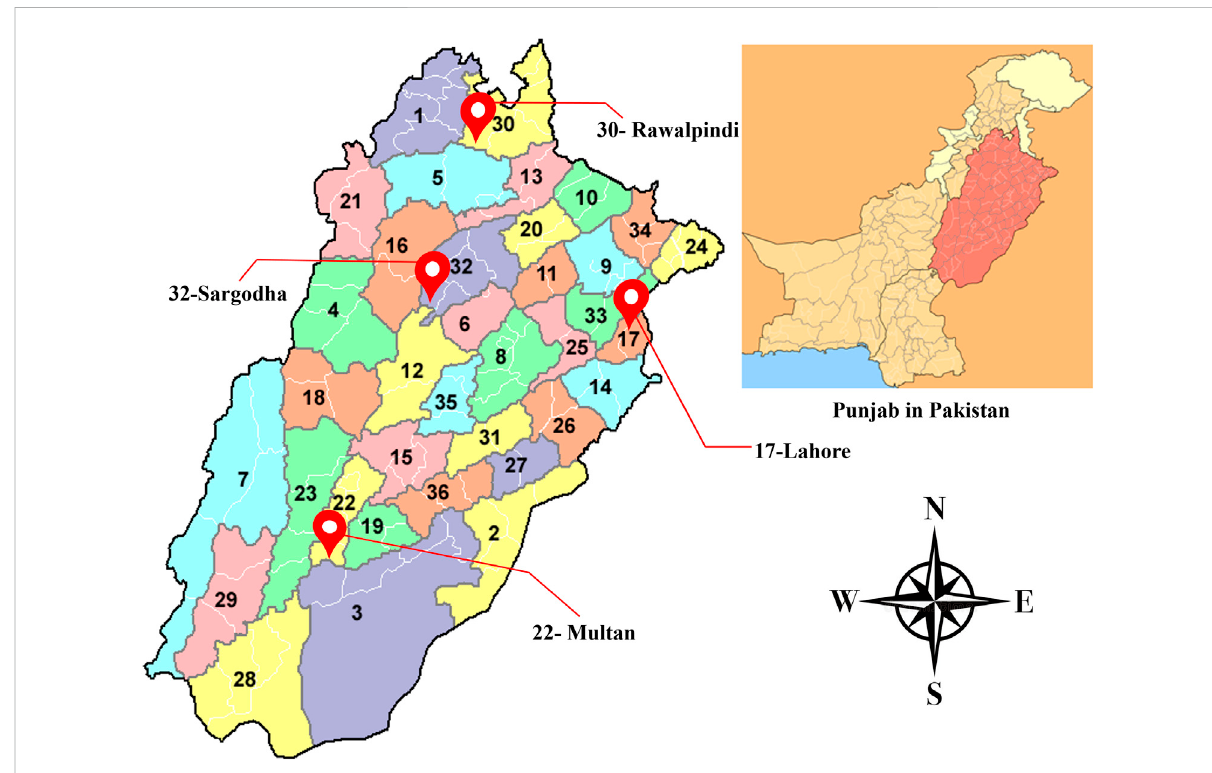
FIGURE 3 Geographical locations of selected SME clusters in Punjab, Pakistan.